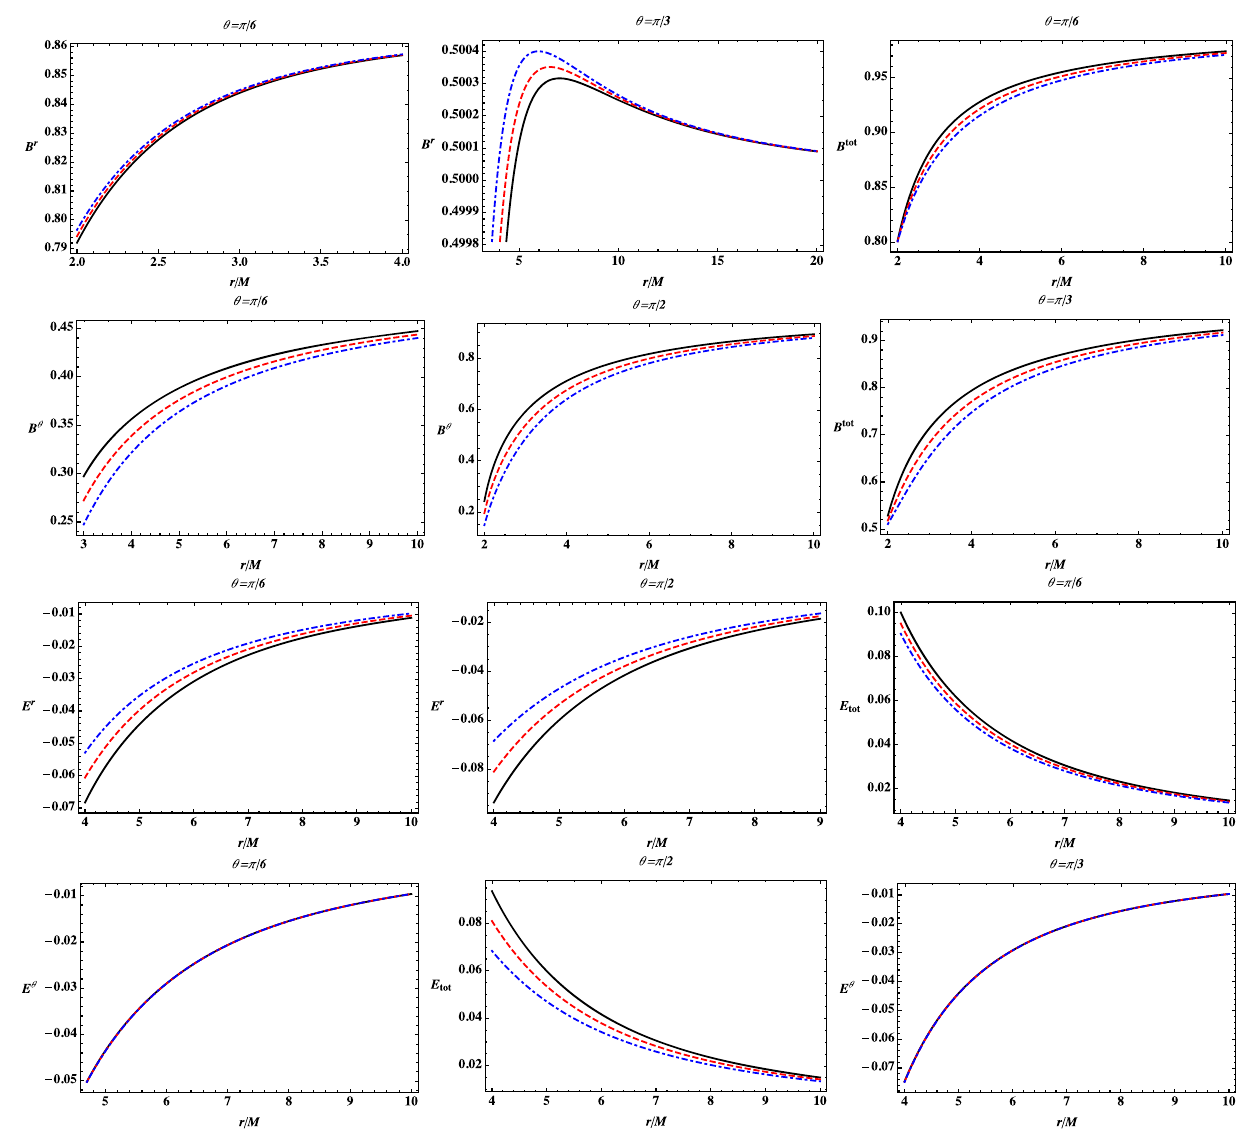
Fig. 1 Radial dependence of the electric and magnetic fields for different values of θ . All graphics are plotted in the case of B = 1 and M = 1. Black solid lines correspond to L 2 = 0, while dashed red lines and blue dot-dashed lines to L 2 = 0 . 2 and L 2 = 0 . 4,